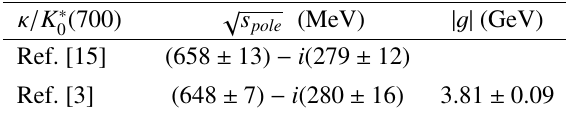
Table 2. κ/ K ∗ (700) dispersive pole determinations using Roy-Steiner 0